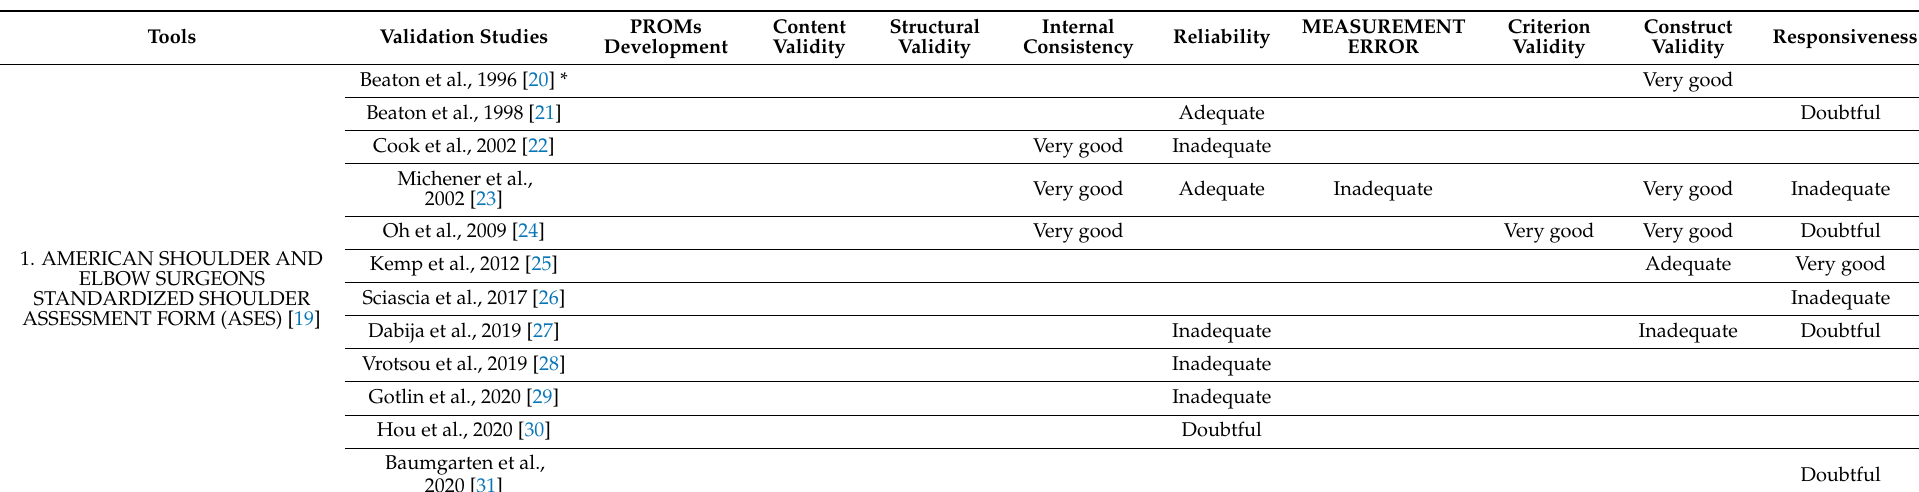
Table 4. Assessment of methodological quality with COSMIN Risk of Bias